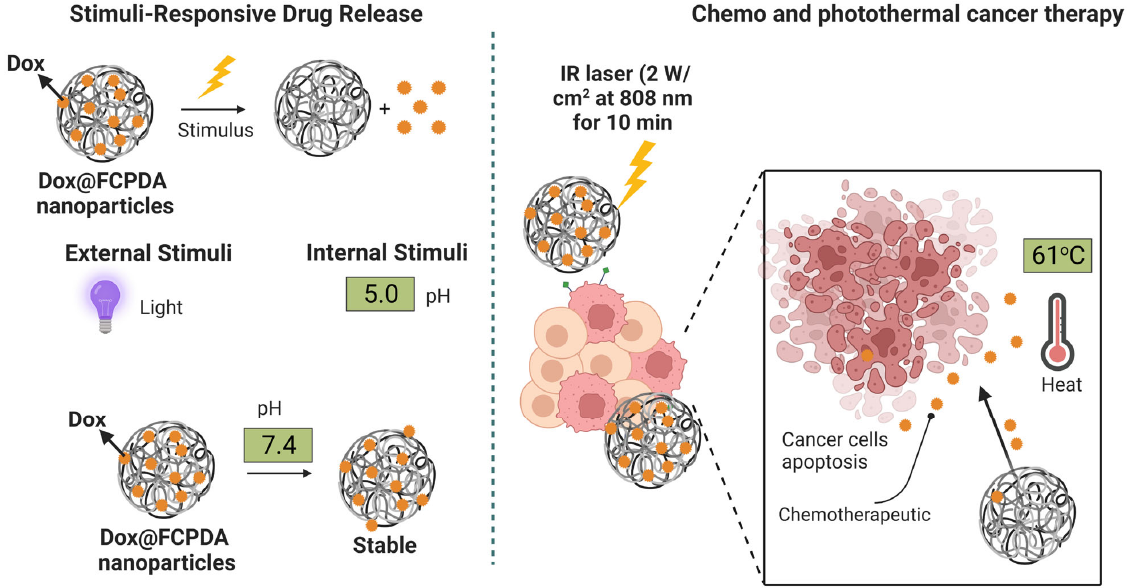
Figure 6. Schematic representation of stimuli-responsive (pH and NIR active) Dox release from FCPDA nanoparticles, and its influence on the cancer cell apoptosis with effect to the synergetic action (Dox and heat) when irradiated at 808 nm for 10 min (2 W/cm 2 ) (The image was created in Bio render).